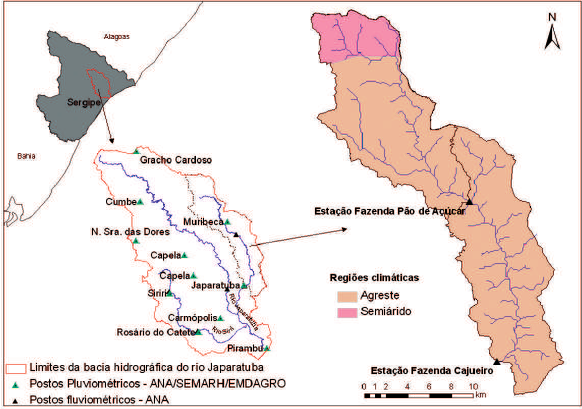
Figura 1. Bacia do Rio Japaratuba e a sub-bacia do Rio Japaratuba Mirim com as estações fluviométricas localizadas na Fazenda Cajueiro (CJ) e Fazenda Pão de Açúcar